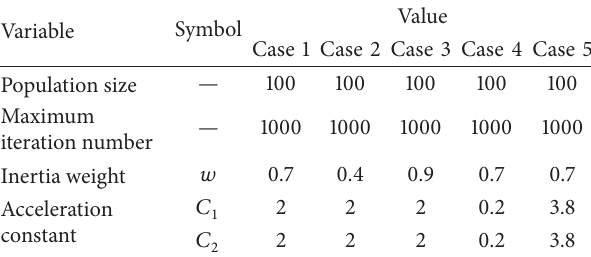
Table 4: The parameters of each case in Figures 8 and